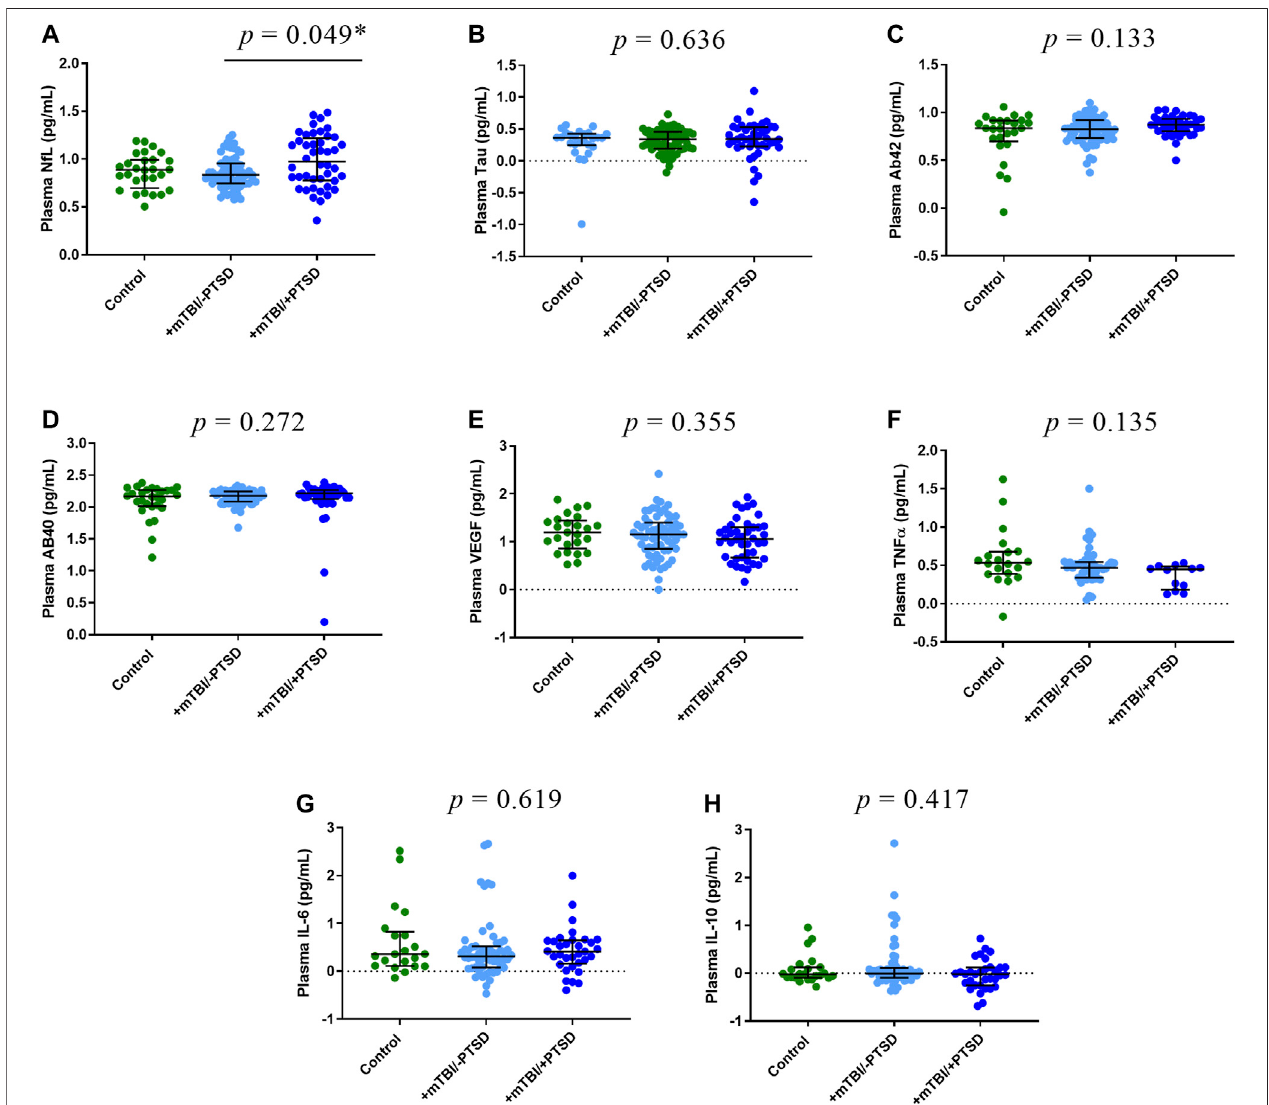
FIGURE 3 | Plasma levels of protein biomarkers. Participants were classi fi ed into three groups based on TBI history and severity of PTSD symptoms as measured by the PTSD Checklist forDSM-5 (PCL-5): 1) Control (i.e., -TBI and -PTSD); 2) +mTBI/-PTSD; 3) +mTBI/+PTSD. Group comparisonswere performed byusingKruskal- Wallis test followed by Dunn ’ s test, and Bonferroni method to correct for multiple comparisons. p values refer to pairwise comparisons (A) or to overall group comparisons (B – H) . Biomarker concentrations were represented as median ± IQR. Concentrations were log transformed to improve data visualization in the graphs. Abbreviations: Neuro fi lament light (NfL), Amyloid beta 42 (AB42), Amyloid beta 40 (AB40), interleukin 6 (IL-6), interleukin 10 (IL-10), tumor necrosis factor -alpha (TNF- α ), and endothelial growth factor (VEGF).